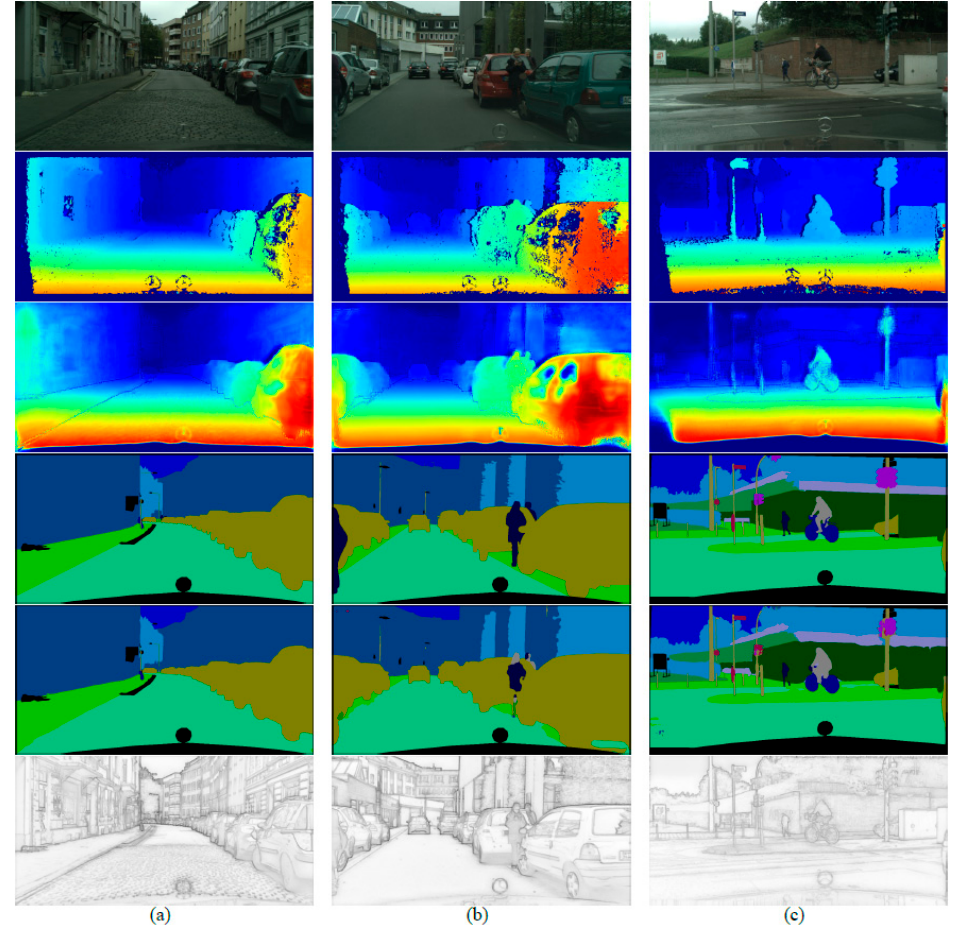
Figure 5. Qualitative results of the SSDNet in the CityScapes dataset. ( a ) and ( b ) show the scenes of large objects, such as vehicles and buildings. ( c ) shows the scene of small objects, such as riders and traffic signs. Top-down order for each column: RGB color image, depth (disparity) groundtruth, depth completion prediction, semantic ground truth, semantic prediction and boundary prediction.